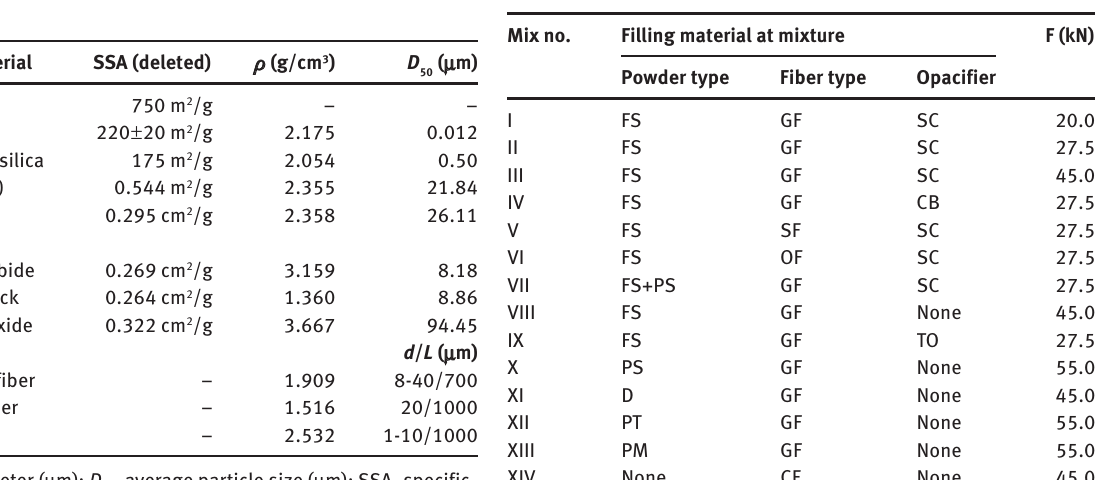
Table 3 Physical properties of powder filling material, opacifier, and fibers.